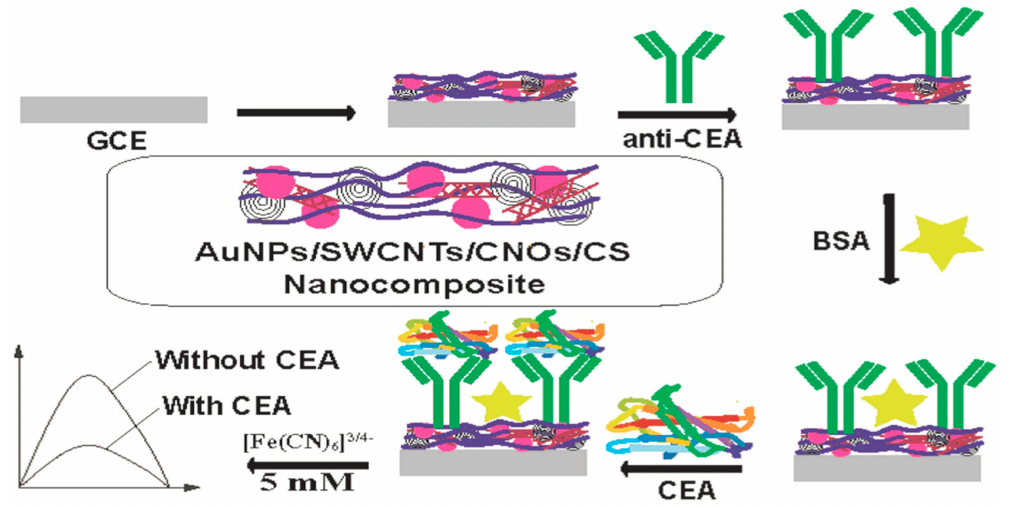
Figure 2. Construction steps of AuNPs/CNOs/SWCTNs/CS/anti–CEA biosensor. SWCNTs: single– walled carbon nanotubes; CNOs: carbon nano–onions; CS: chitosan; BSA: Bovine serum albumin. Reprinted with permission from [42], published by Elsevier,